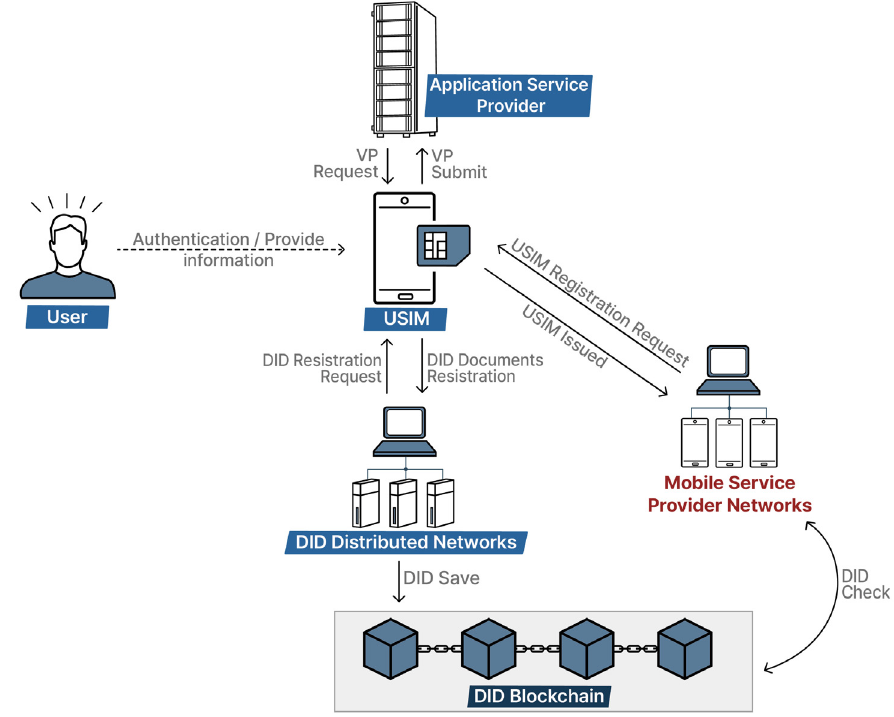
Figure 6. The architecture of the proposed technique.